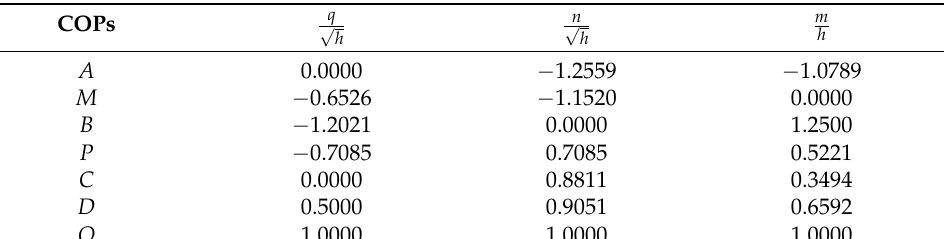
Table 2. The characteristic parameters of COPs on the q / corresponding to n s = 24.6.